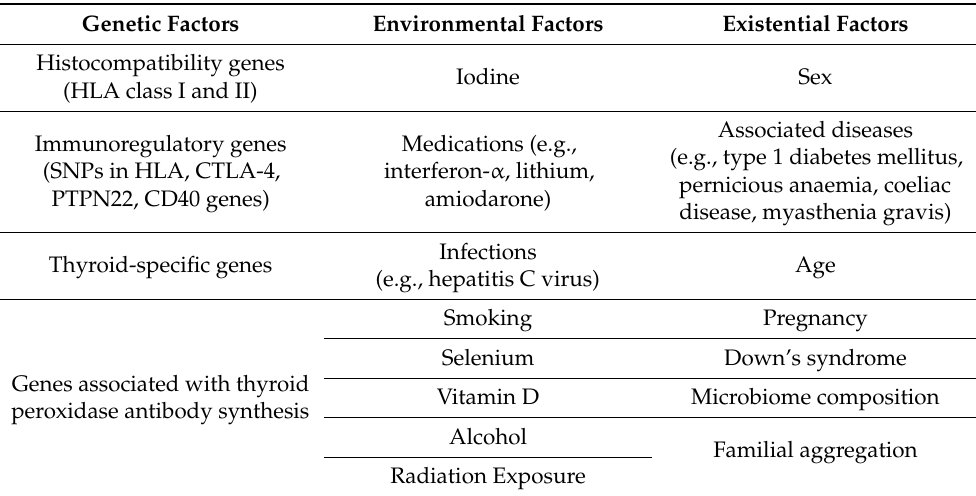
Table 1. Genetic, environmental and existential factors associated with Hashimoto’s thyroiditis [2,4,6,7,9,17,18,20]. Genetic Factors Environmental Factors Existential Factors Histocompatibility genes Iodine Sex (HLA class I and II) Associated diseases Medications (e.g., Immunoregulatory genes (e.g., type 1 diabetes mellitus, interferon- α , lithium, (SNPs in HLA, CTLA-4, pernicious anaemia, coeliac amiodarone) PTPN22, CD40 genes) disease, myasthenia gravis) Infections Age Thyroid-specific genes (e.g., hepatitis C virus) Smoking Pregnancy Selenium Down’s syndrome Genes associated with thyroid Vitamin D Microbiome composition peroxidase antibody synthesis Alcohol Familial aggregation Radiation